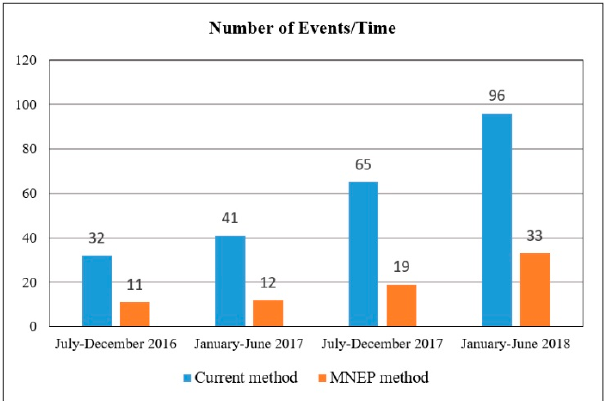
Figure 5. Comparison of the total of all events between July 2016 and June 2018.